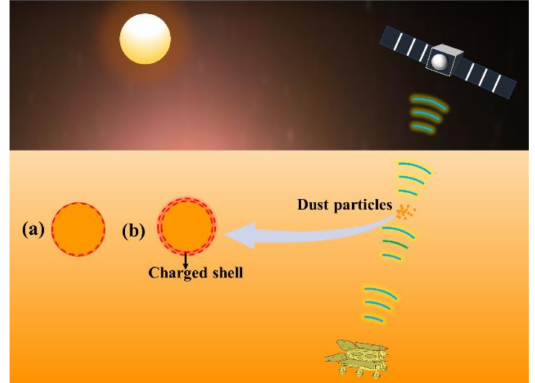
Figure 1. Schematic of the remote sensing of Martian atmospheric dust. ( a ) A dust particle with a charged shell that is much thinner than the particle size, which is assumed to form a surface current of zero-thickness [28]. ( b ) A dust particle with a charged shell that has a thickness comparable to the particle size, which can be described by a Core-Shell model [29].